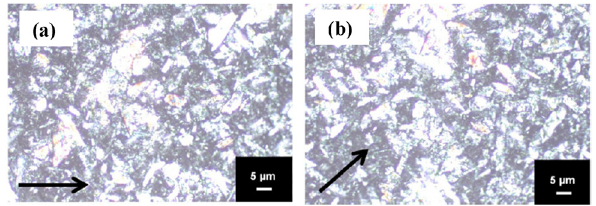
Figure 8: Polarized light microscopy images of ( a ) 5 v/v% CNW - reinforced composite within the magnetic fi eld, ( b ) 5 v/v% CNW - reinforced composite rotated by 45° to the polarization axis. Adapted from ref. [ 61 ] .